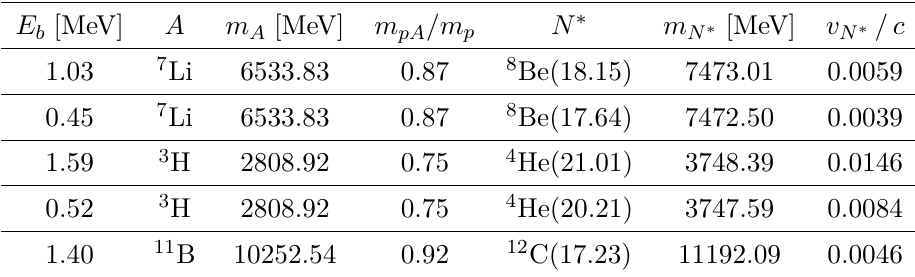
Table 5 . Proton kinetic energy E b , mass of the target and of the excited nucleus, reduced proton- target mass and velocity of the excited nucleus produced by the collision in the lab frame at the resonance peak ( E = m ) for all the measured N ∗ states. CM N ∗